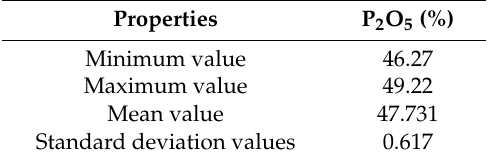
Table 1. Statistics of the Effective Constituents of Compound Fertilizer Samples.